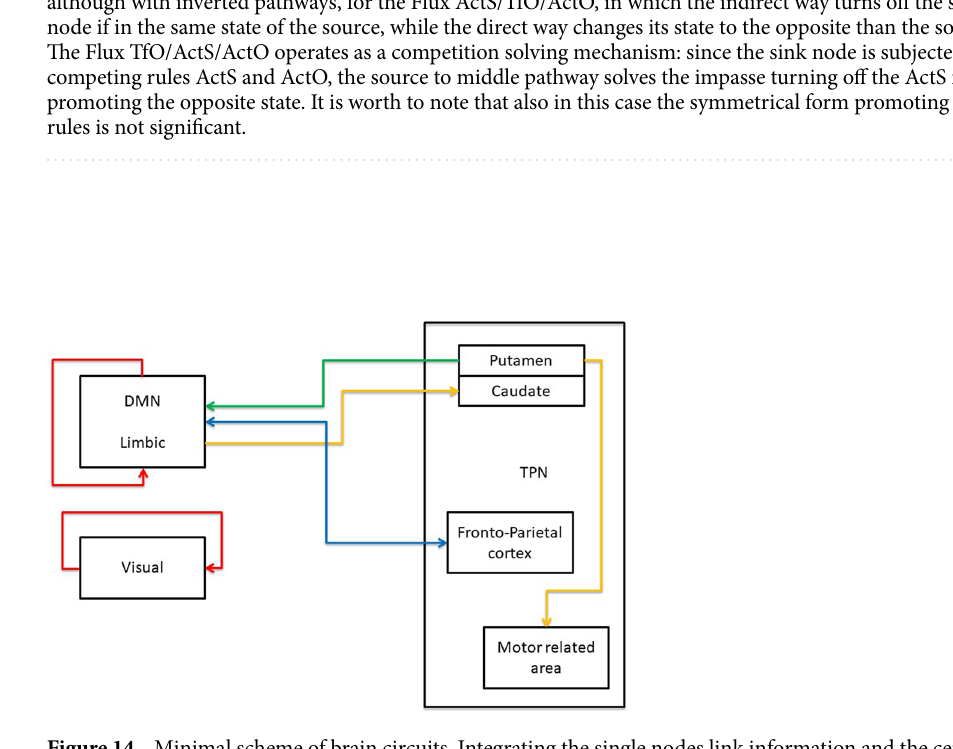
Figure 14. Minimal scheme of brain circuits. Integrating the single nodes link information and the centrality analysis within the network modularity architecture, different patterns of brain areas are associated to a specific rule (for details see ‘Centrality and modularity analyses’ section). Red line = ActS; orange line = Tfs; blue line = ActO; violet line =